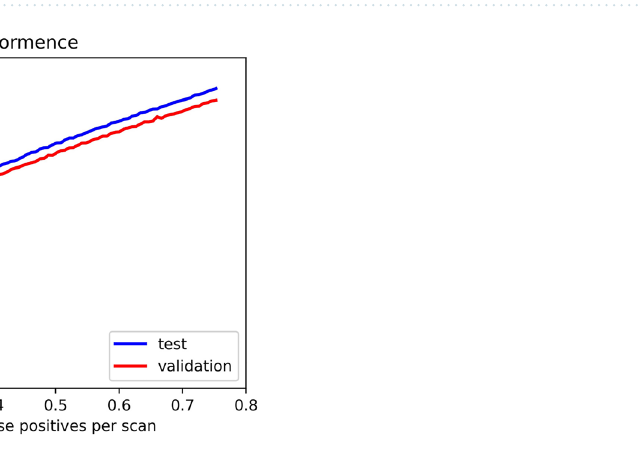
Figure 4. Free-response ROC (FROC) curve for our